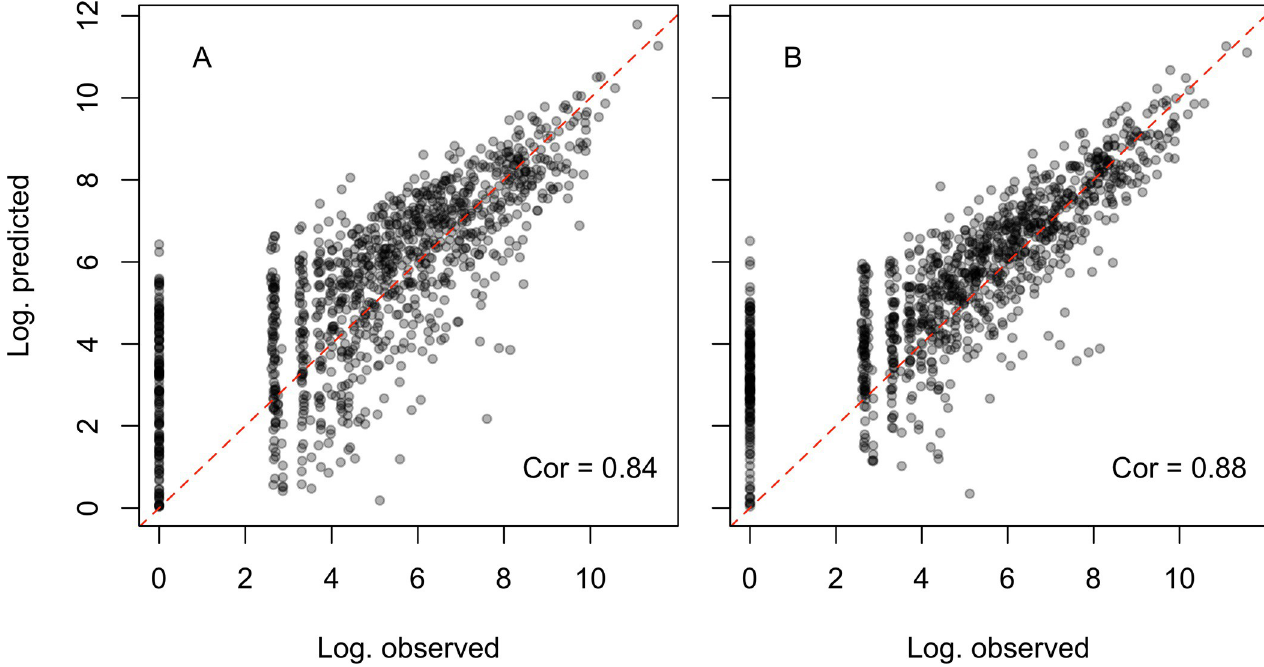
Fig 4. Estimated versus observed migration flows (in log scale) between each pair of departments with estimated flows (A) based on the results of the fine-scale model, aggregated to the department level, and (B) based on the results of the broad-scale model.